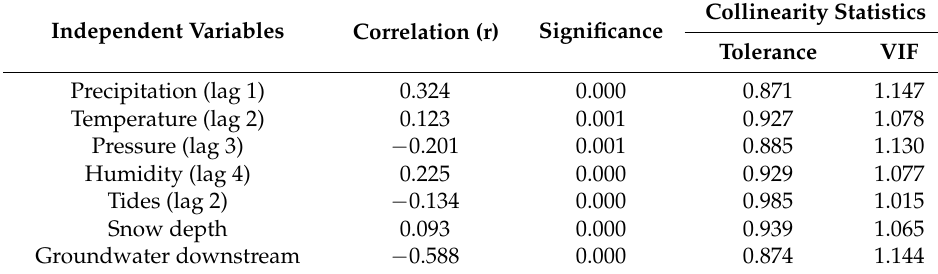
Table 5. The correlation (r) values are reported for the short-term component between the water discharge and the predictor variables. The second column describes the significance level for each predictor variable derived from the TSR model, the third column the collinearity tolerance, and the fourth column describes the variance inflation factor (VIF). The lag values are indicated within the parentheses.